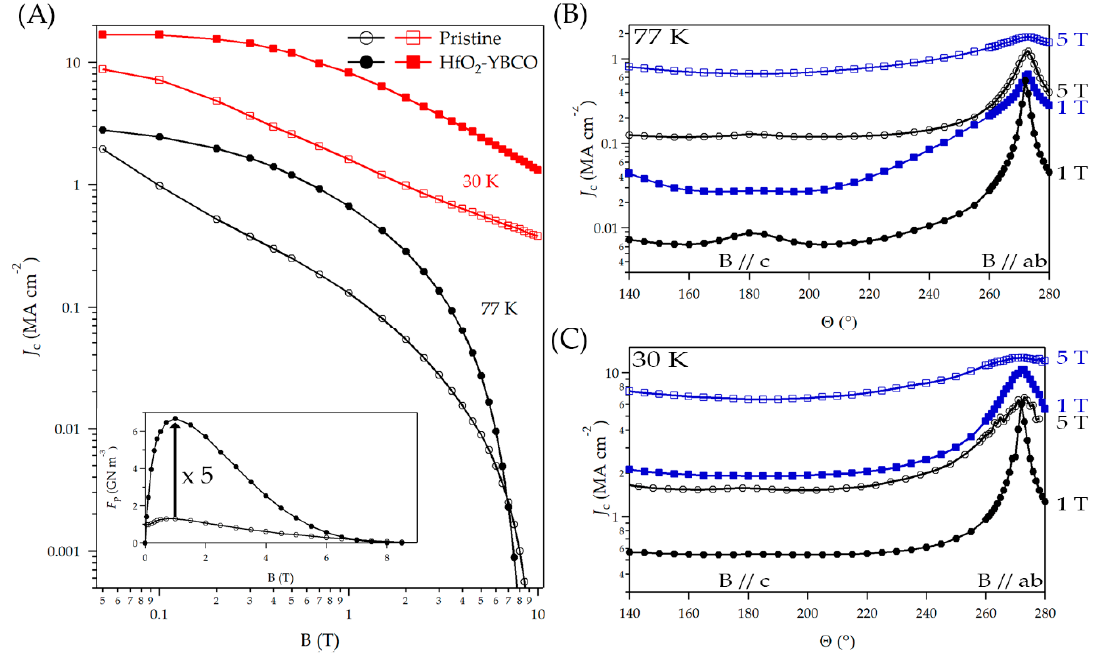
Figure 6. ( A ) Magnetic field dependence of J c of the around 500-nm thick YBCO film with (closed symbol) and without (open symbol) HfO 2 nanocrystal additions at two temperatures: 30 K (red) and 77 K (black). The inset shows the corresponding pinning force density F p at 77 K. Angular dependence of J c at 1 T (closed symbol) and 5 T (open symbol) at 77 K ( B ) and 30 K ( C ) for pristine (black) and HfO 2 -YBCO (blue) films.